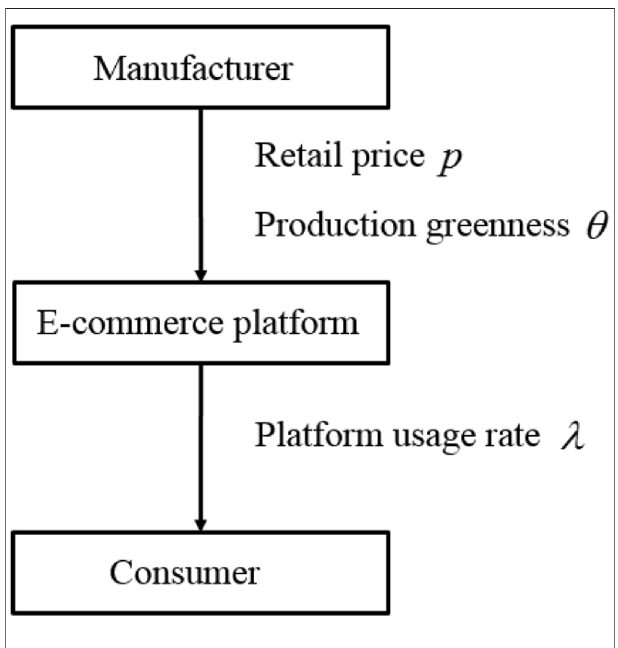
FIGURE 1 | Structure of the supply chain